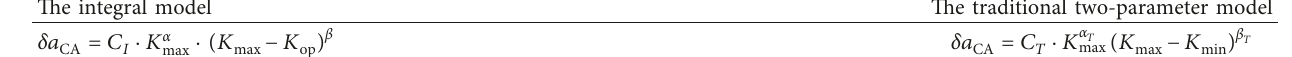
Table 2: The crack increments in the whole loading path [15]. The integral model The traditional two-parameter model